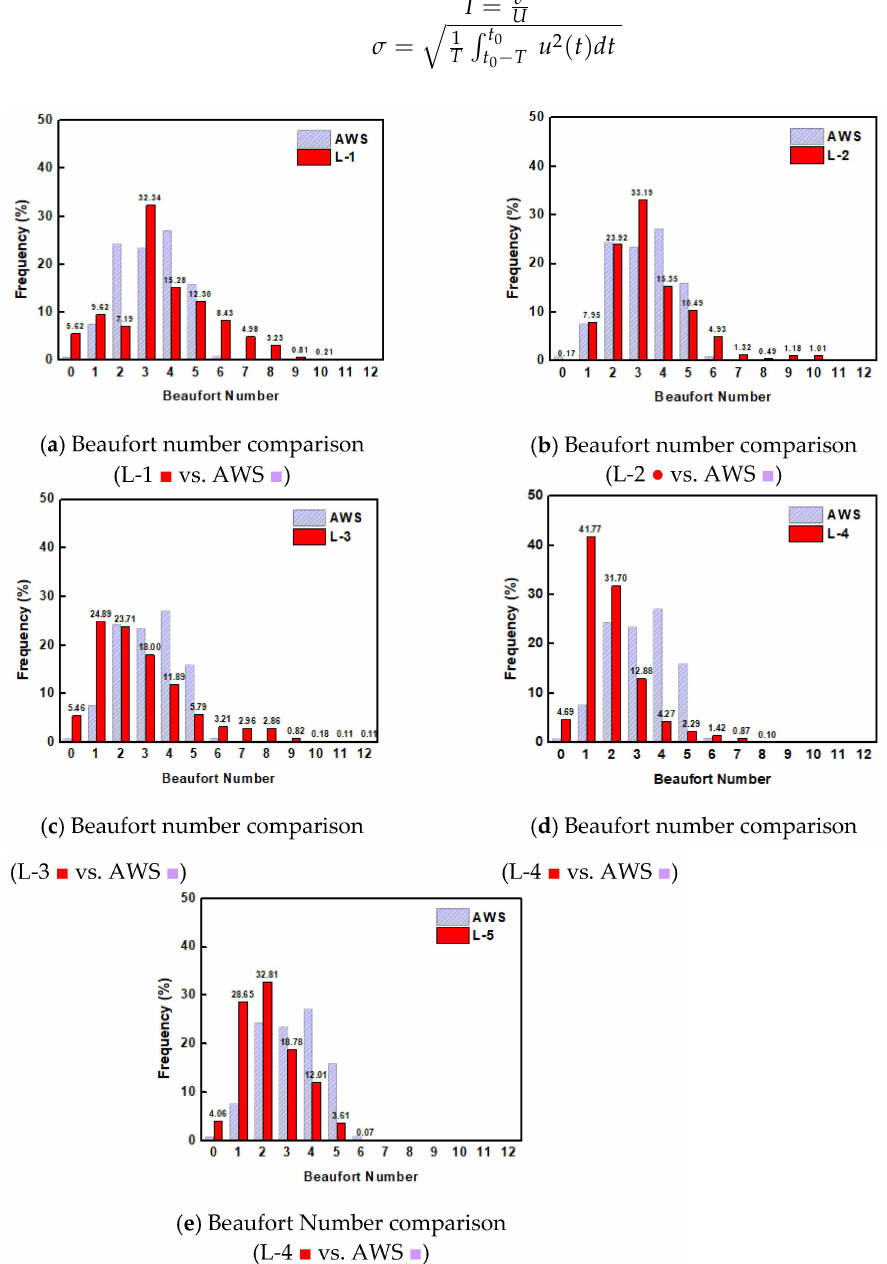
Figure 13. Frequency of the Beaufort numbers at each point for LCT ( a – e ) L-1 to L-5 ( (cid:4) ), respectively, vs. AWS ( (cid:4)